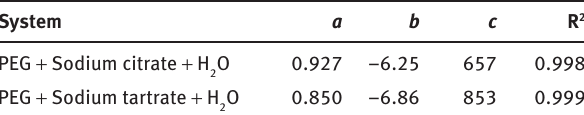
Table 3: Fitted parameters of the Merchuk equation for the two studied ATPS’s and coefficient of determination R 2